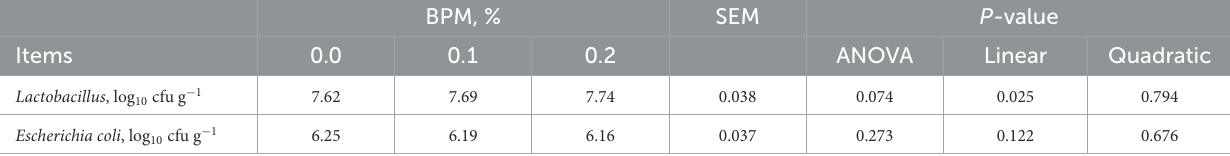
TABLE 5 Effect of dietary supplementation of Bacillus subtilis and Pichia farinose mixture (BPM) on cecal bacteria counts of broiler chicks ∗ . BPM, % SEM P -value Items 0.0 0.1 0.2 Linear